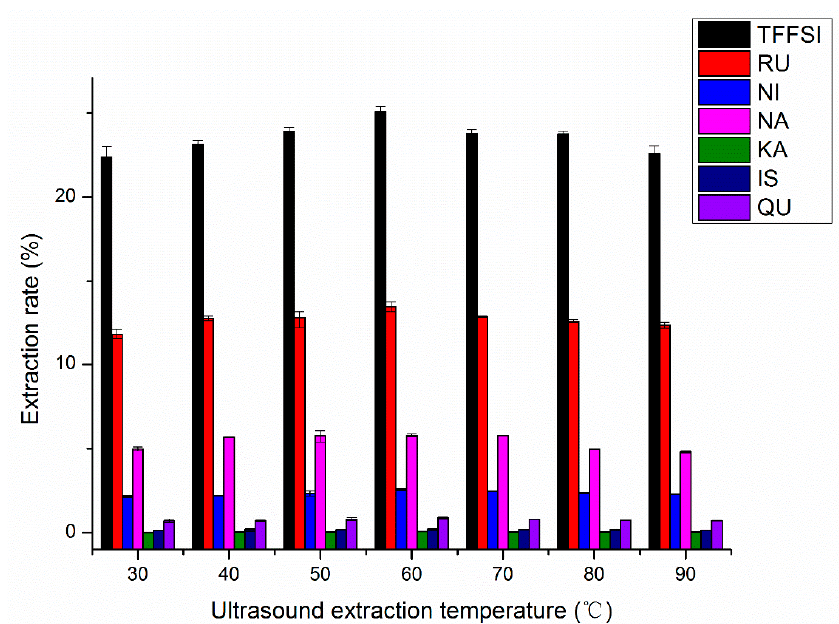
Figure 6. Effects of the ultrasound extraction temperature on the extraction rates of RU, NI, NA, KA, IS, QU, and the TFFSI.